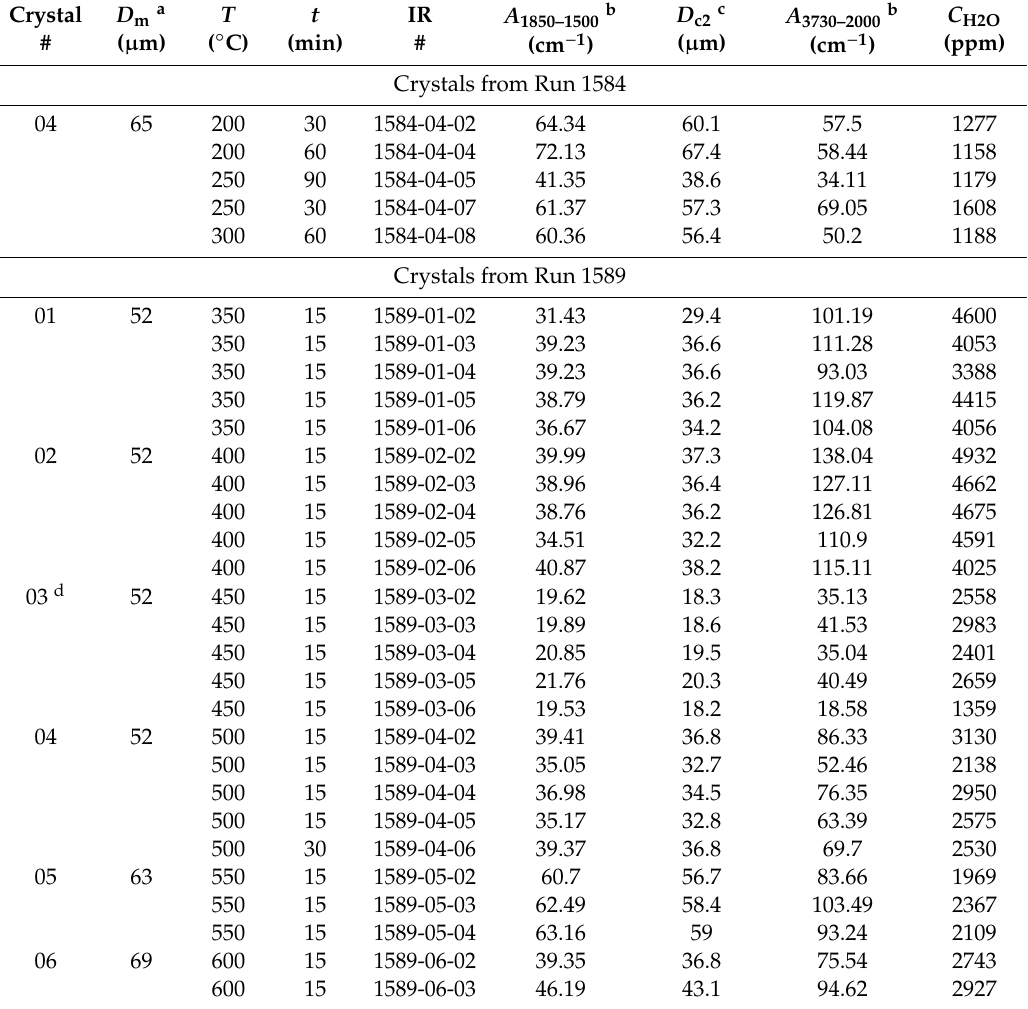
Table 2. Ambient unpolarized IR experiments performed on doubly-polished Mg-Rw thin sections, annealed at various temperatures ( T ) for various durations ( t ) and quickly quenched to room T